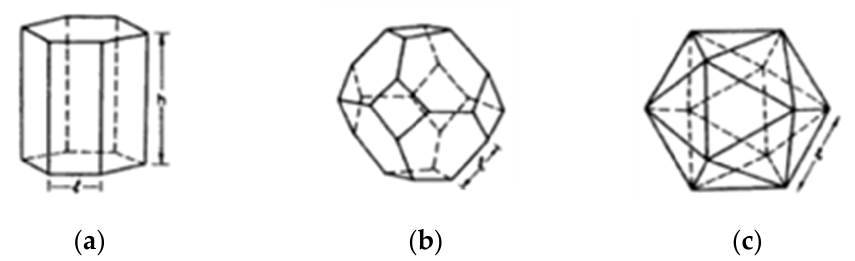
Figure 3. ( a ) Hexagonal with rectangular cell; ( b ) Truncated octahedron; ( c ) Icosahedron.